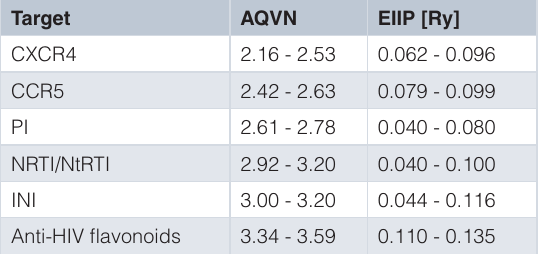
Table 6. AQVN and EIIP range of anti-HIV drugs 6